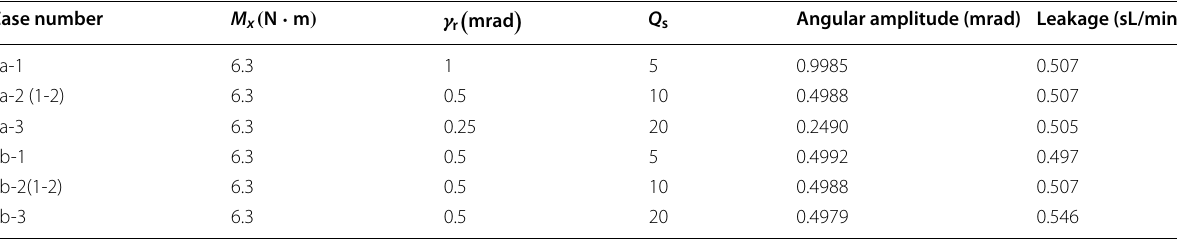
Table 3 Groups 2a and 2b: Changes of the supports behind the stator Case